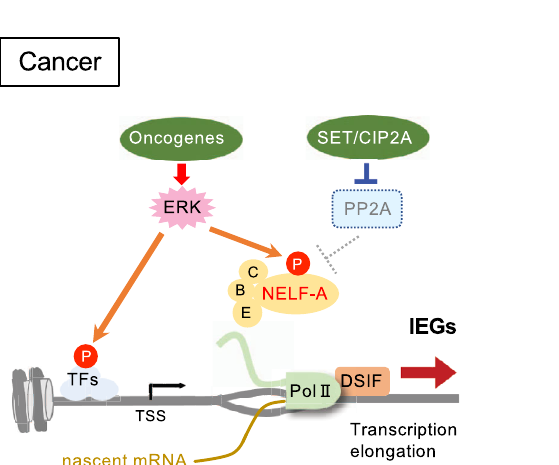
Fig. 8 | PP2A inhibitor proteins promote tumor progression by upregulating growth-promoting genes in human cancers. a , b Analyses of SET ( a ) and CIP2A ( b ) mRNA expression innormal, cancer tissues, and cancer subsets with mutations in the indicated oncogenes based on the TCGA-TARGET-GTEx databases. Each horizontal bar represents the mean. Error bars, SEM. Numbers in parentheses indicate sample sizes. Numbers on the graph represent the percentage of patients with SET- or CIP2A-high cancers. Cancers in which SET or CIP2A expression is higherthanthetop5%levelofthecorrespondingnormaltissuesarede fi nedasSET- or CIP2A-high. P -values were assessed using a one-way ANOVA Tukey test. *** p <1.4×10 − 10 . c Relative expression levels (fold change) of IEGs and growth- promoting genes in KRAS-mutated pancreatic cancers with high (top 10%; n =9) and low(bottom 10%; n =9) expression ofSET orCIP2A. A totalof 87samples with RNAseq data were obtained from the ICGC dataset. d , e Scatter plots showing the